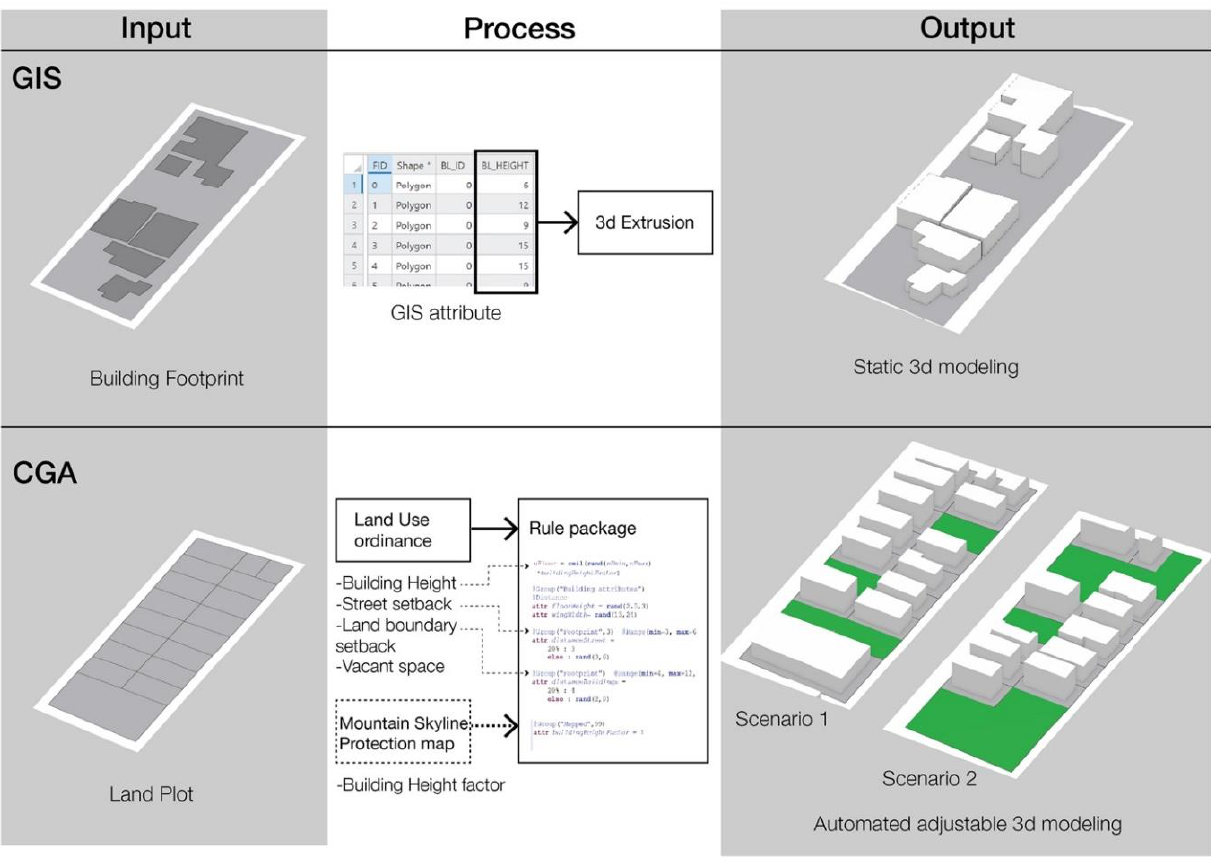
Figure 7. GIS 3d extrusion and CGA 3d modeling (Source: Authors).